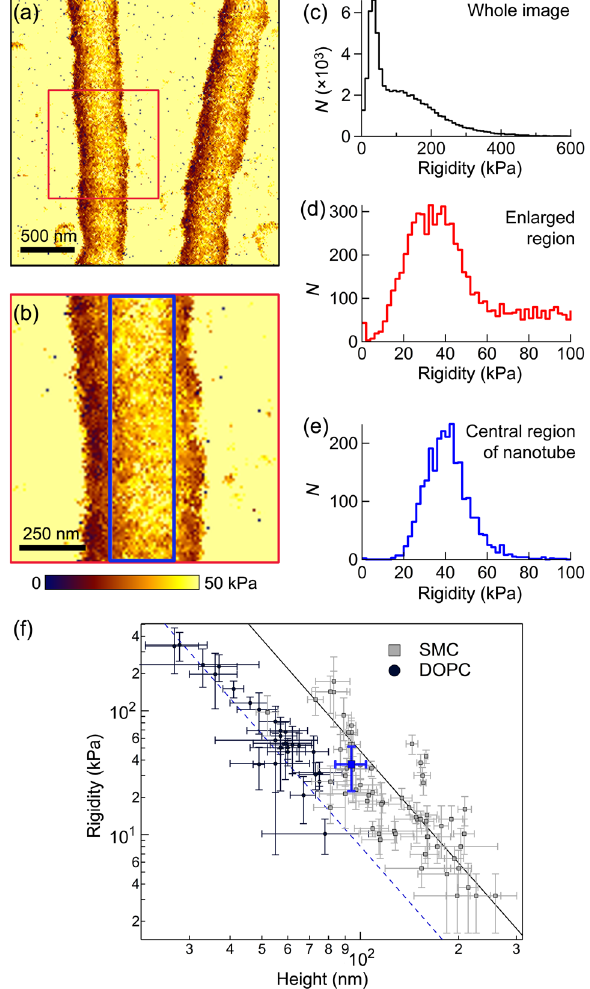
FIG. 10. Measuring the rigidity of a nanotube. (a) AFM rigidity map of two nanotubes. Red square: region enlarged in (b).